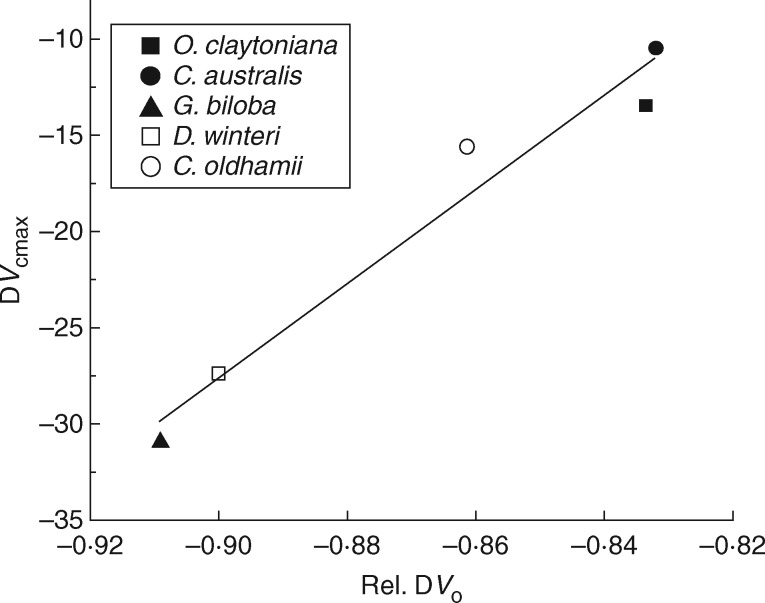
Relationship (y = 244x + 192, r2 = 0·95, P = 0·003) between the relative observed changes in the in situ oxygenation rate [Rel. DVO  = (VOamb – VOTJB)/VOamb] and the corresponding changes in the maximum rate of carboxylation (DVCmax). DVCmax data are differences resulting after subtraction of the mean values of the ambient treatment (400 ppm CO2, 21 % O2) from the corresponding values of the TJB (1900 ppm CO2, 16 % O2) treatment.